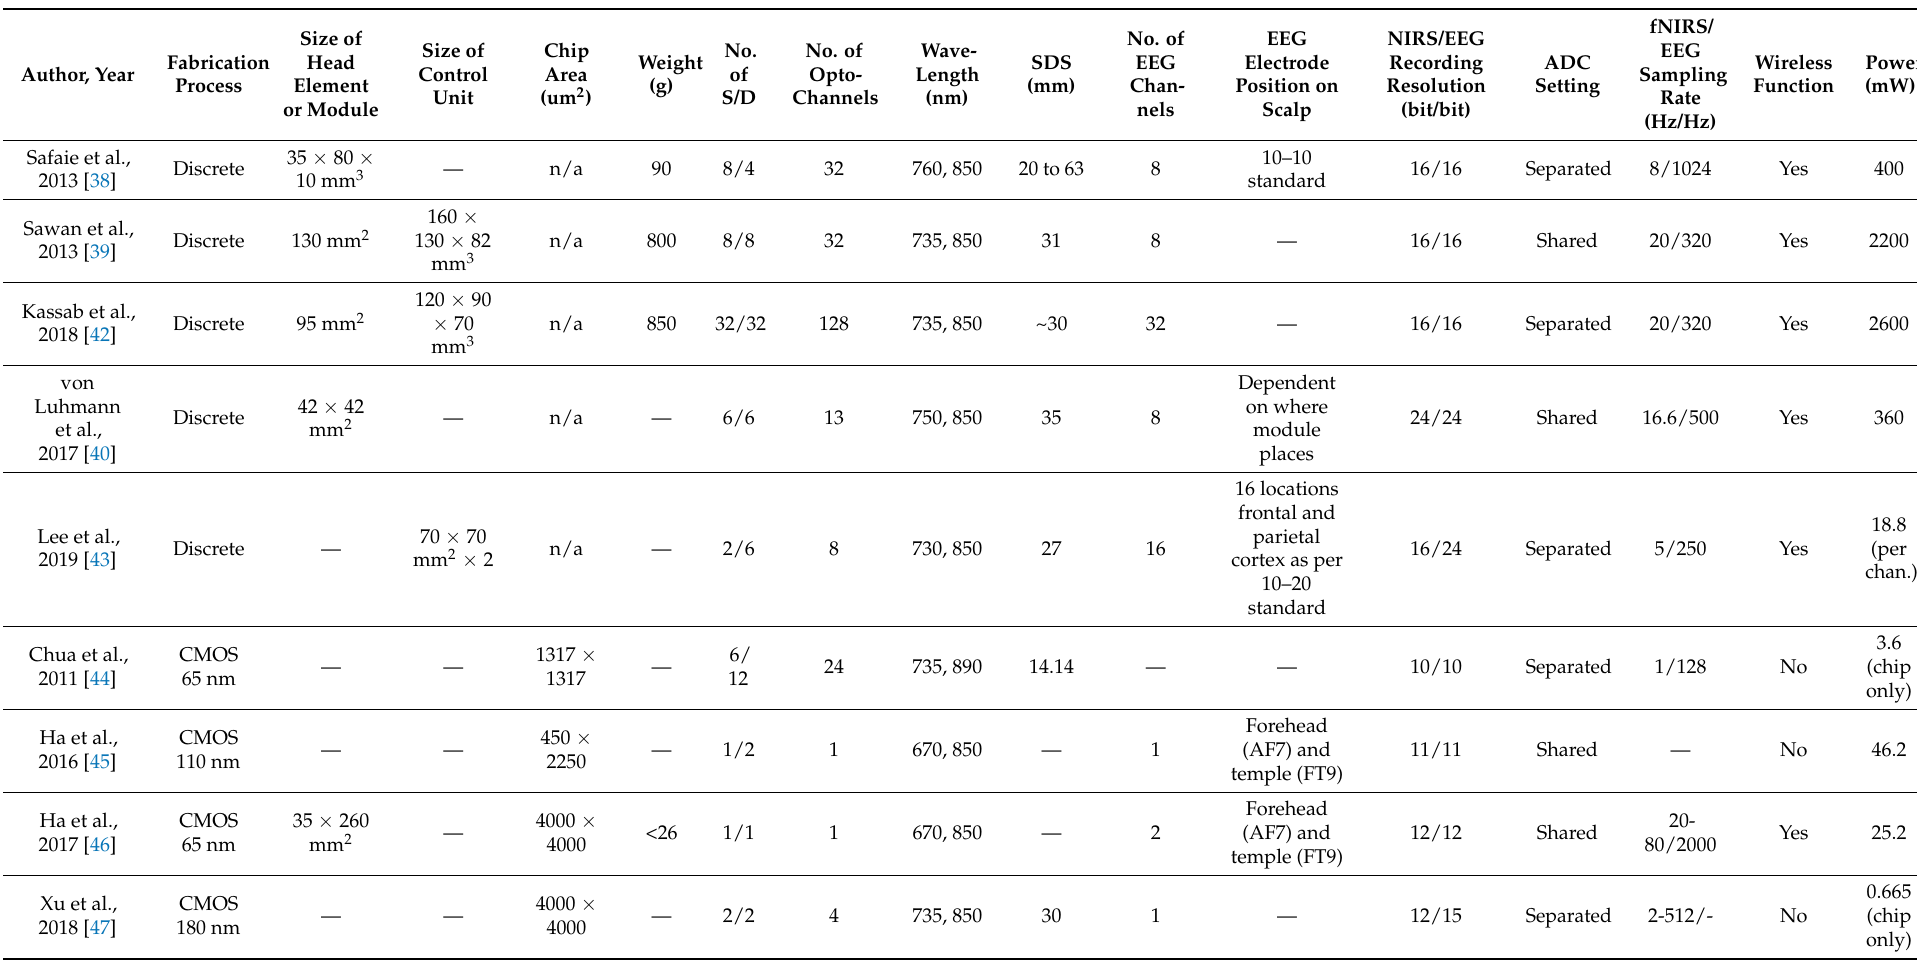
Table 1. Characteristics of key wearable, integrated EEG–fNIRS technologies. Note: the use of “n/a” indicates that the specific characteristic (e.g., chip area) is not applicable to that system. The em dash (—) symbol indicates that the information is not